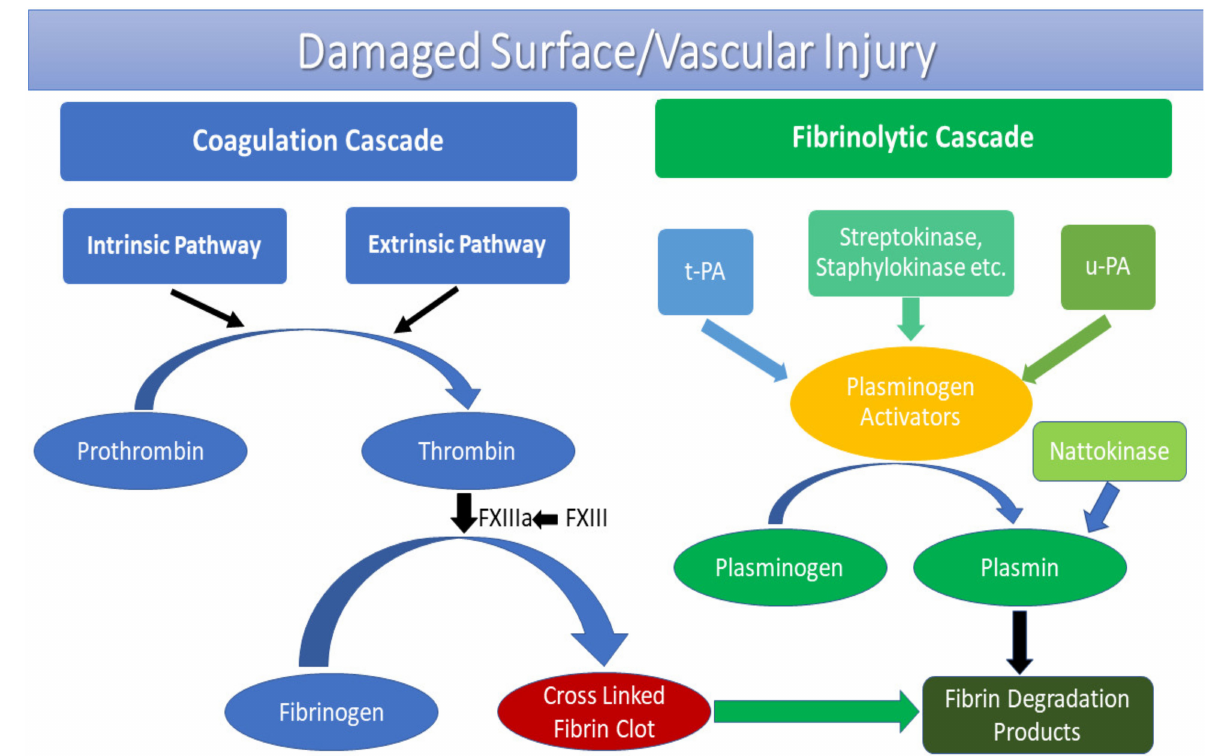
Figure 1. In vivo working mechanism of microbial fibrinolytic